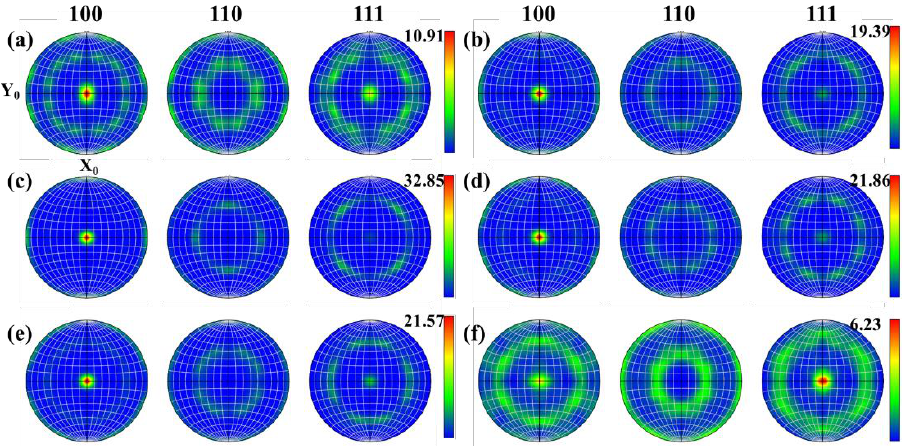
Figure 15. Pole figures of Mo–1.5wt%ZrO 2 molybdenum alloy at a strain rate of 0.01 s − 1 : ( a ) 1000 ◦ C ( b ) 1100 ◦ C, ( c ) 1200 ◦ C, ( d ) 1300 ◦ C, ( e ) 1400 ◦ C, ( f ) 1500 ◦